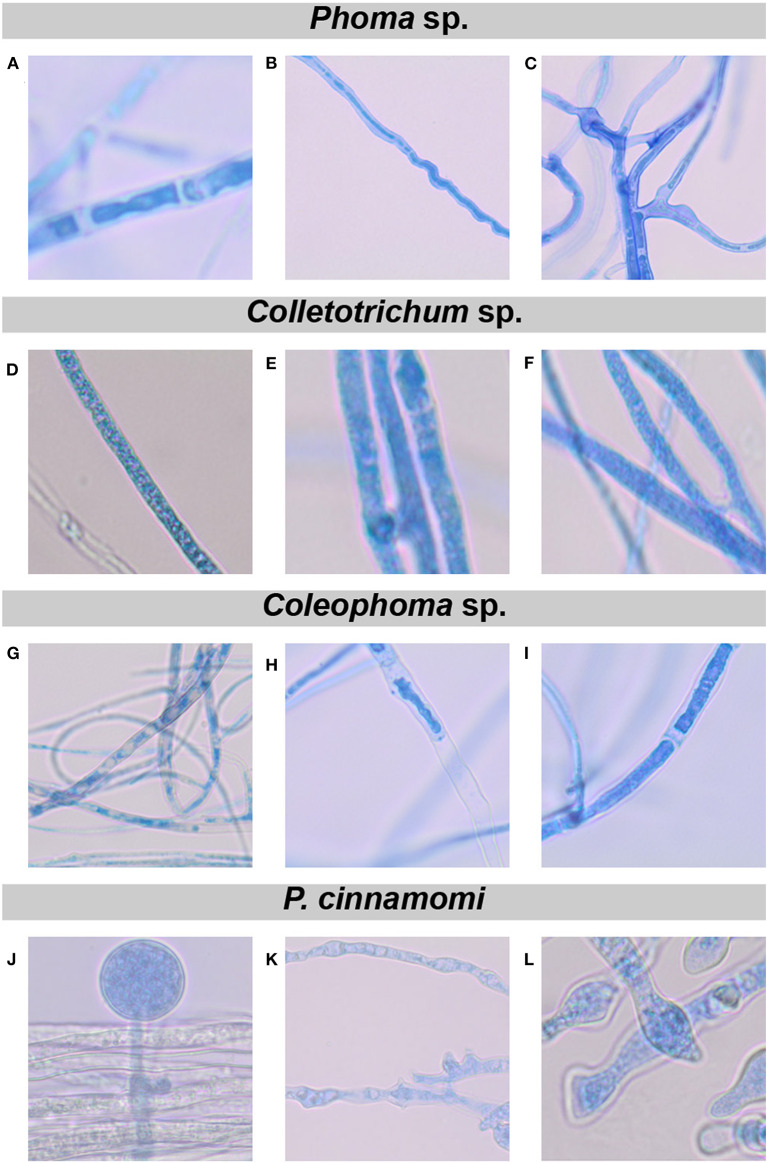
Morphological changes in Phoma sp. (A–C), Colletotrichum sp. (D–F), Coleophoma sp. (G–I) and Phytophthora cinnamomi
(J–L), by bVOCs produced by C. vaccinii MWU328. The column ADGJ represents untreated hyphae for each of the fungi. Columns BEHK and CFIL show hyphae from each of the fungi after exposure to bVOCs. (B,D,G,K) Are shown at 40x magnification, and (A,C,E,F,H,I,J, L) are shown at 100x.